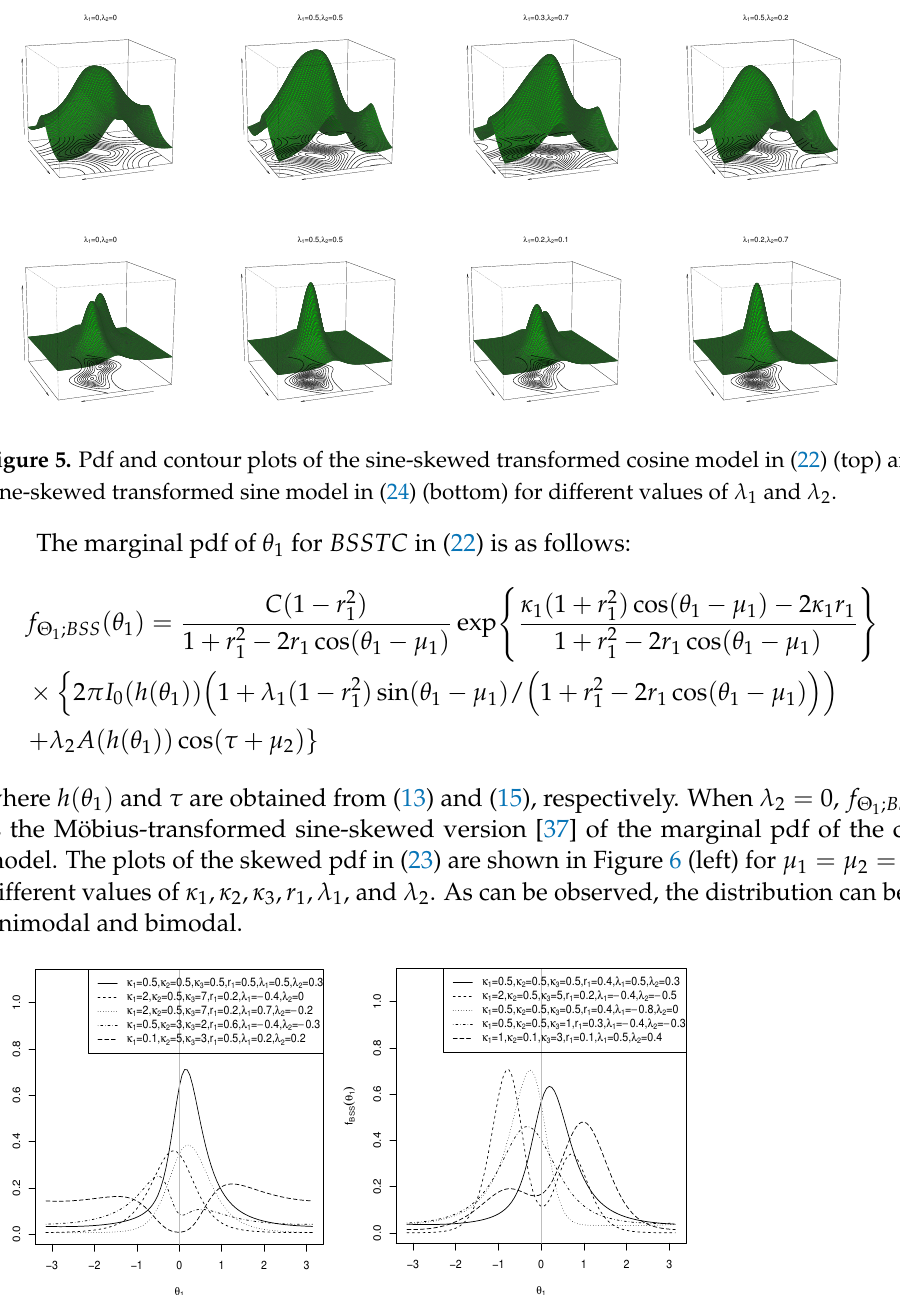
Figure 6. Plots of the marginal pdf of Θ 1 for BSSTC ( left ) and BSSTS ( right ) for µ 1 = µ 2 = 0 and different parameter